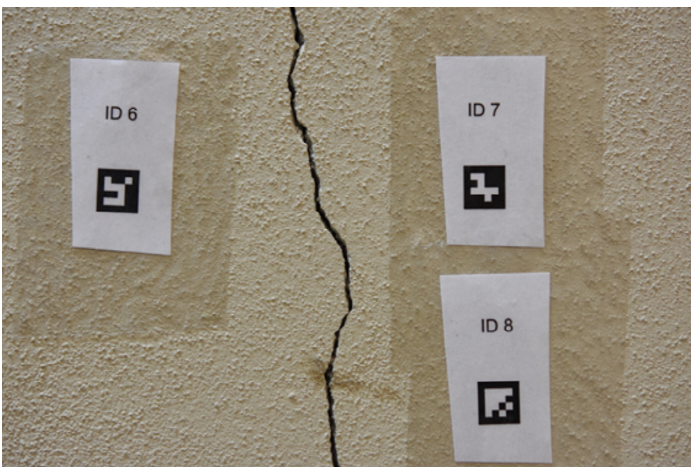
Figure 32. Target concrete wall